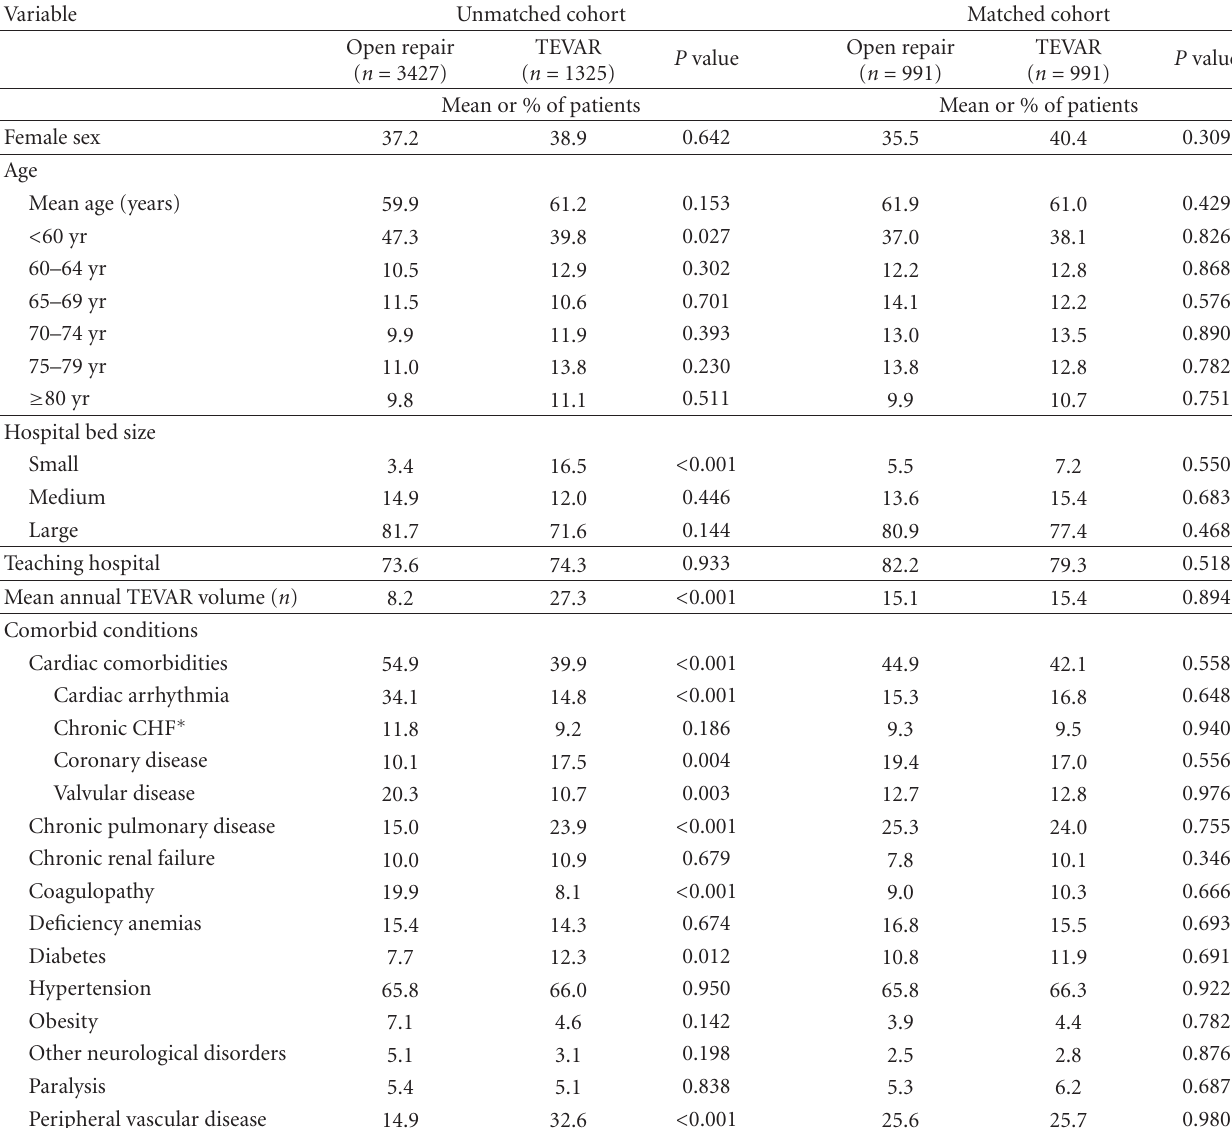
Table 2: Baseline characteristics of emergently admitted patients undergoing open surgical repair or TEVAR for type B dissections from 2005 to